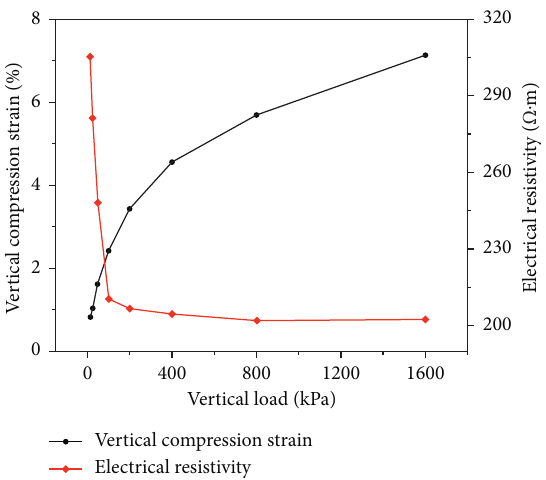
Figure 5: Vertical compression strain-vertical loads-electric resistivity curve of